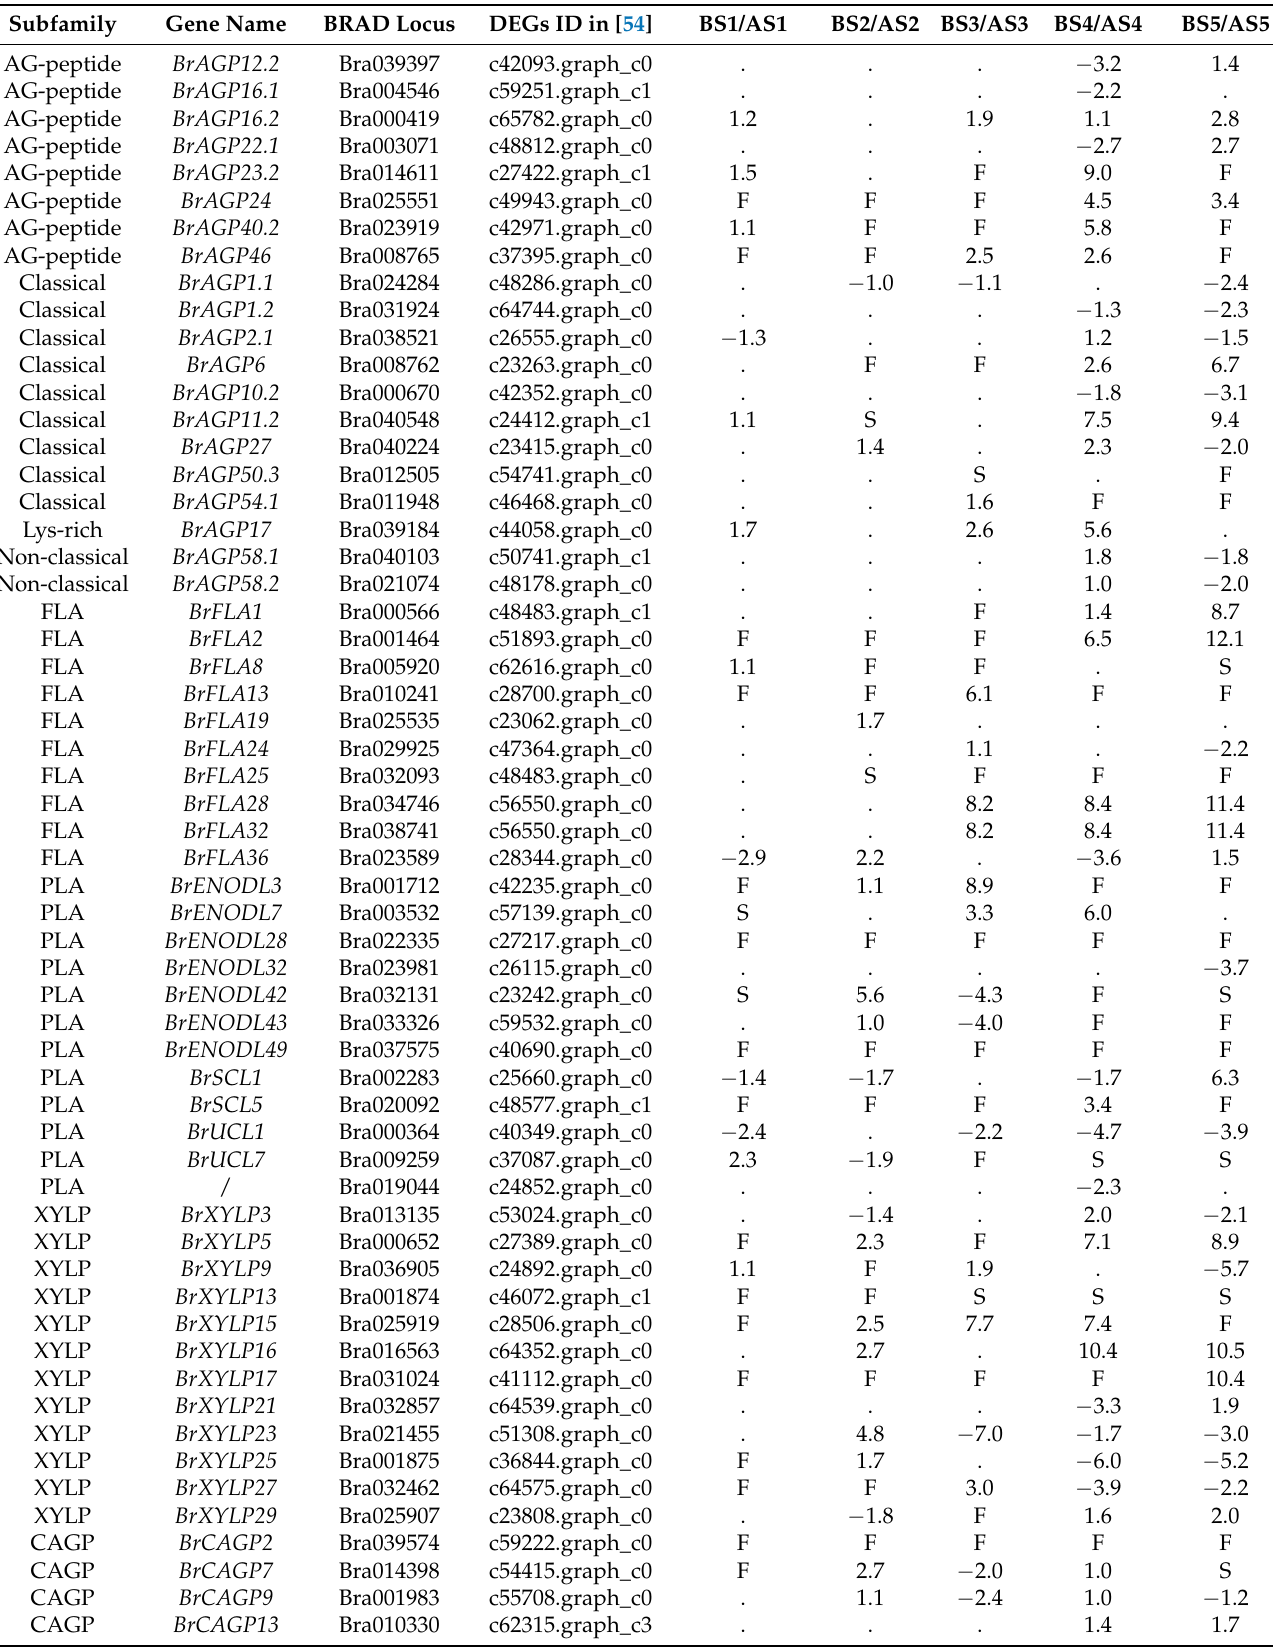
Table 1. List of differentially expressed BrAGP genes in floral buds from male-sterile ‘ Bcajh97-01A ’and male-fertile ‘ Bcajh97- 01B ’ of Brassica rapa